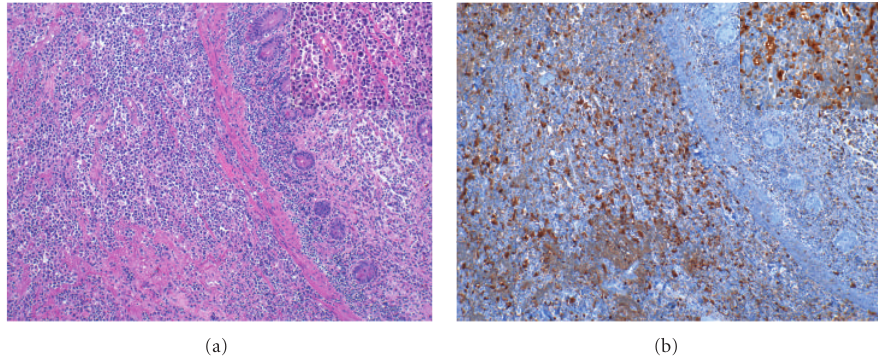
Figure 3: Immunohistochemical stain of thymidine phosphorylase (TP) expression in a gastrointestinal biopsy specimen from a patient with enteropathy-type T-cell lymphoma. (a) Hematoxylin and eosin stain. (b) TP stain highlights neoplastic T cells (arrow in inset; 400x). Images are from an Olympus BX41 microscope (Olympus Corp., Tokyo, Japan) processed with Qcapture Pro 5.1 (QImaging, Surrey, BC,